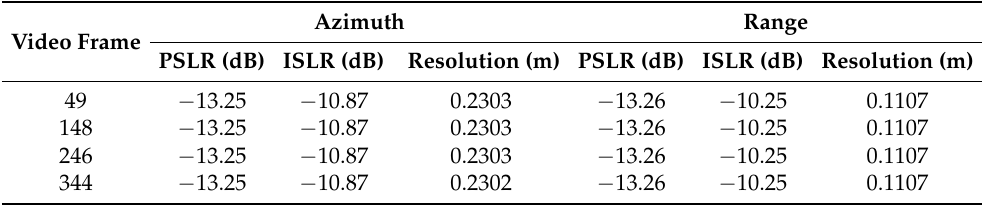
Table 4. Evaluation of Focusing Quality In Point Target’s Simulation.